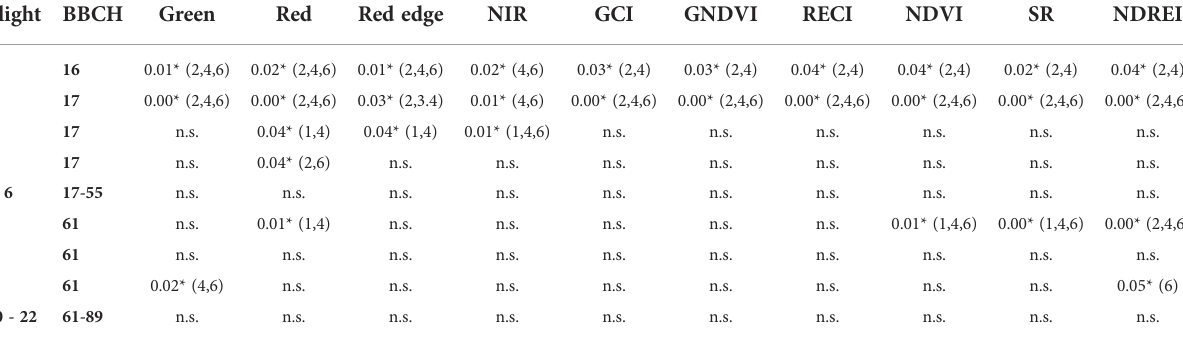
TABLE 3 Spectral differences between row orientations using the Kruskal – Wallis test depicting signi fi cant or non-signi fi cant (n.s.) differences. Flight BBCH